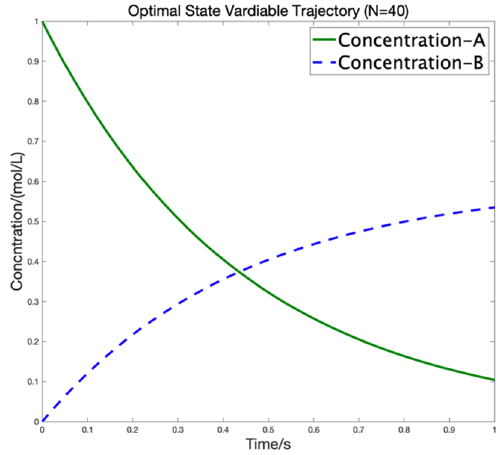
Figure 37. Optimal trajectory of state variables ( N = 40 ).